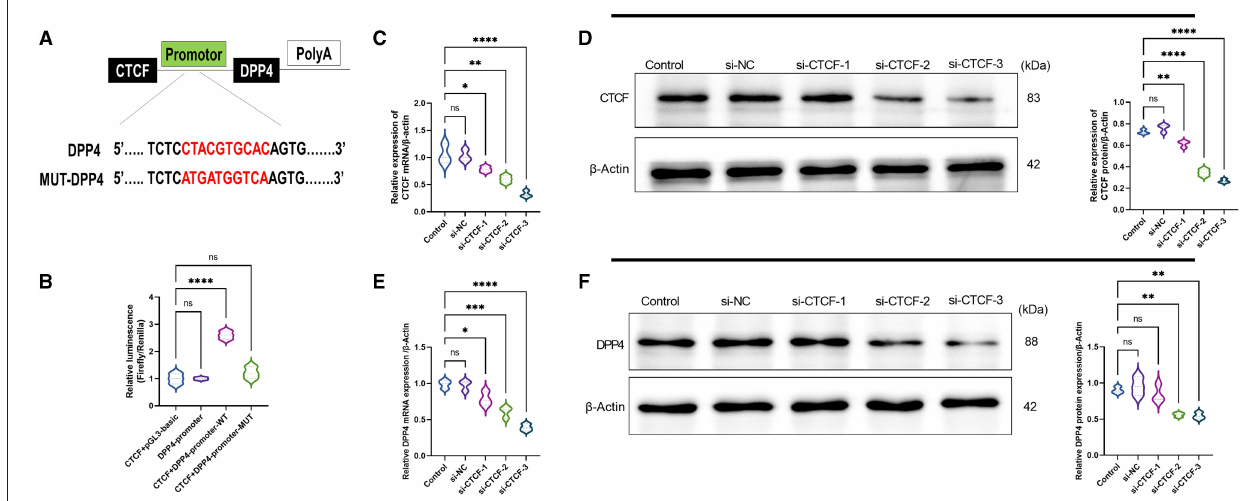
FIGURE 1 | CCCTC-binding factor (CTCF) is a positive regulator of dipeptidyl peptidase-4 (DPP4). (A) Prediction of the targeted binding site between the promoter region of the DPP4 gene and the transcription factor CTCF by MEME suite and JASPAR databases. (B) The predicted binding site between the promoter region of the DPP4 gene and the transcription factor CTCF was verified using a dual-luciferase reporter assay. (C) The relative mRNA expression of CTCF in the untransfected, si-NC, and different si-RNAs of CTCF (si-CTCF) were detected by RT-qPCR. (D) The relative protein expression of CTCF in the untransfected, si-NC, si-CTCF-1, si-CTCF-2, and si-CTCF-3 groups were measured by Western blot. (E) The relative mRNA expression of DPP4 in the untransfected, si-NC, si-CTCF-1, si-CTCF-2, and si-CTCF-3 groups were detected by RT-qPCR. (F) The relative protein expression of DPP4 in the untransfected, si-NC, si-CTCF-1, si-CTCF-2, and si-CTCF-3 groups were measured by Western blot. ns, non-significant, * p < 0.05, ** p < 0.01, *** p < 0.001, and **** p < 0.0001 in the comparison between the indicated